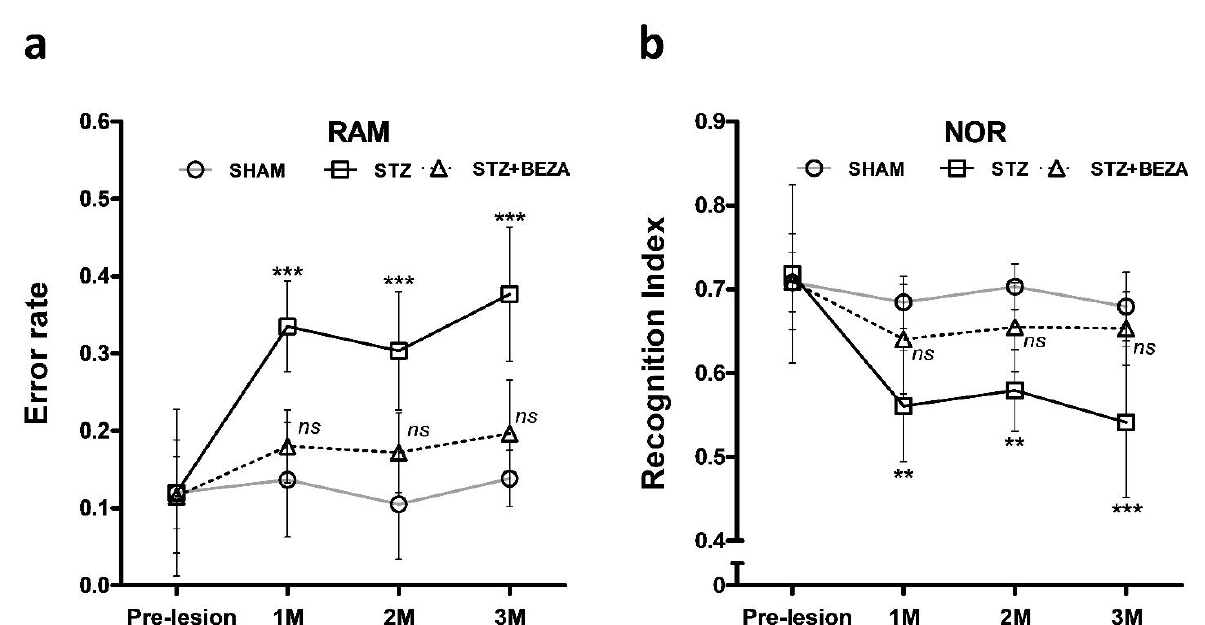
Figure 1. Bezafibrate treatment rescued the STZ-ICV-induced behavioral deficits. ( a ) RAM tests demonstrated that the error rates of the STZ group were significantly higher compared to those of the SHAM group after STZ-ICV administration. The STZ-ICV-induced abnormalities were successfully ameliorated by the 28-day bezafibrate treatment as there was no significant difference in error rates between STZ+BEZA and SHAM groups till the third month. ( b ) NOR tests revealed that the recognition indices in the STZ group were significantly decreased after STZ-ICV administration, while the recognition indices did not differ between STZ+BEZA and SHAM groups untill the third month. Data are presented as mean ±SD; **, p < 0.01, ***, p < 0.001, ns , not significant, vs. SHAM group on the same timepoint; n = 6, per group.